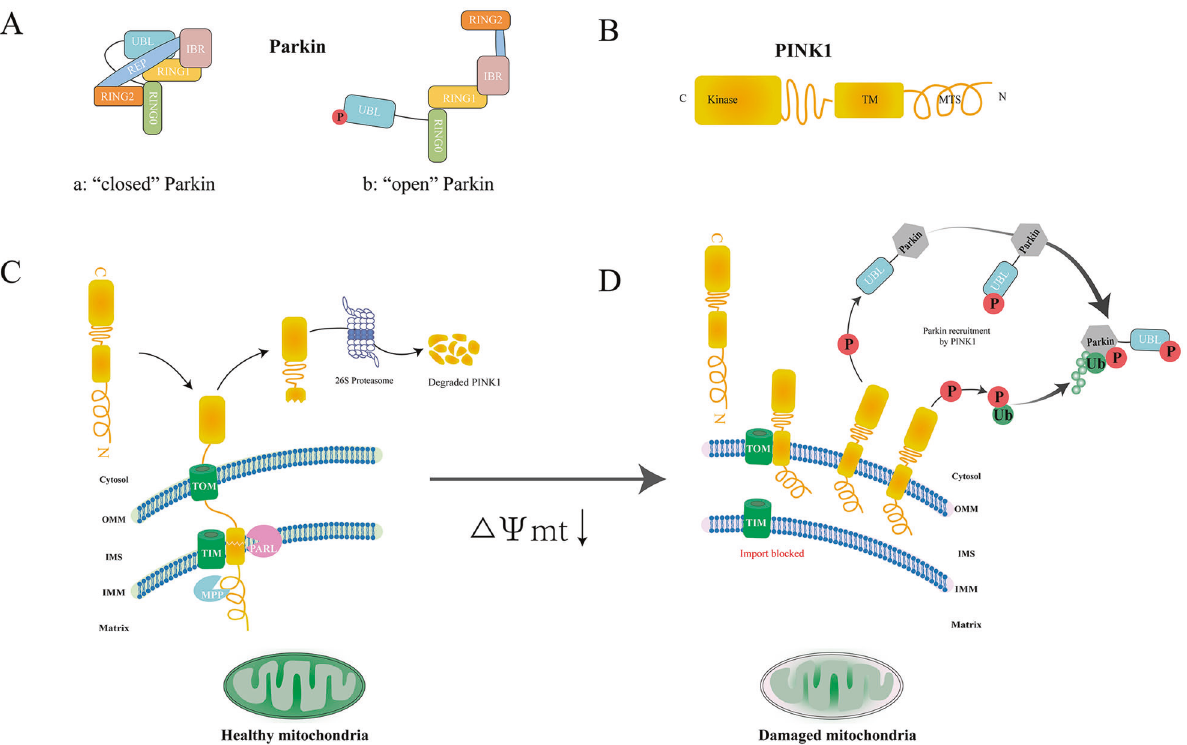
Fig. 1 PINK1/Parkin-mediated mitophagy. A Under normal conditions, the conformation of Parkin is closed, which contains an N-terminal ubiquitin-like (UBL) domain, repressor element of Parkin (REP), four zinc-coordinating RING-like domains: RING0, RING1 (H302 to R305 motif), in-between RING (IBR), and RING2. Once Parkin is activated, its conformation becomes open and the UBL domain is released. B Domain features of PINK1: PINK1 possesses a Ser/Thr kinase domain (Kinase) close to C-terminal, followed by an α -helical transmembrane (TM) segment, and N-terminal mitochondrial targeting sequence (MTS). C PINK1 is continuously imported into healthy mitochondria then degraded. D Positive cycles for PINK1 and Parkin Recruitment on damaged